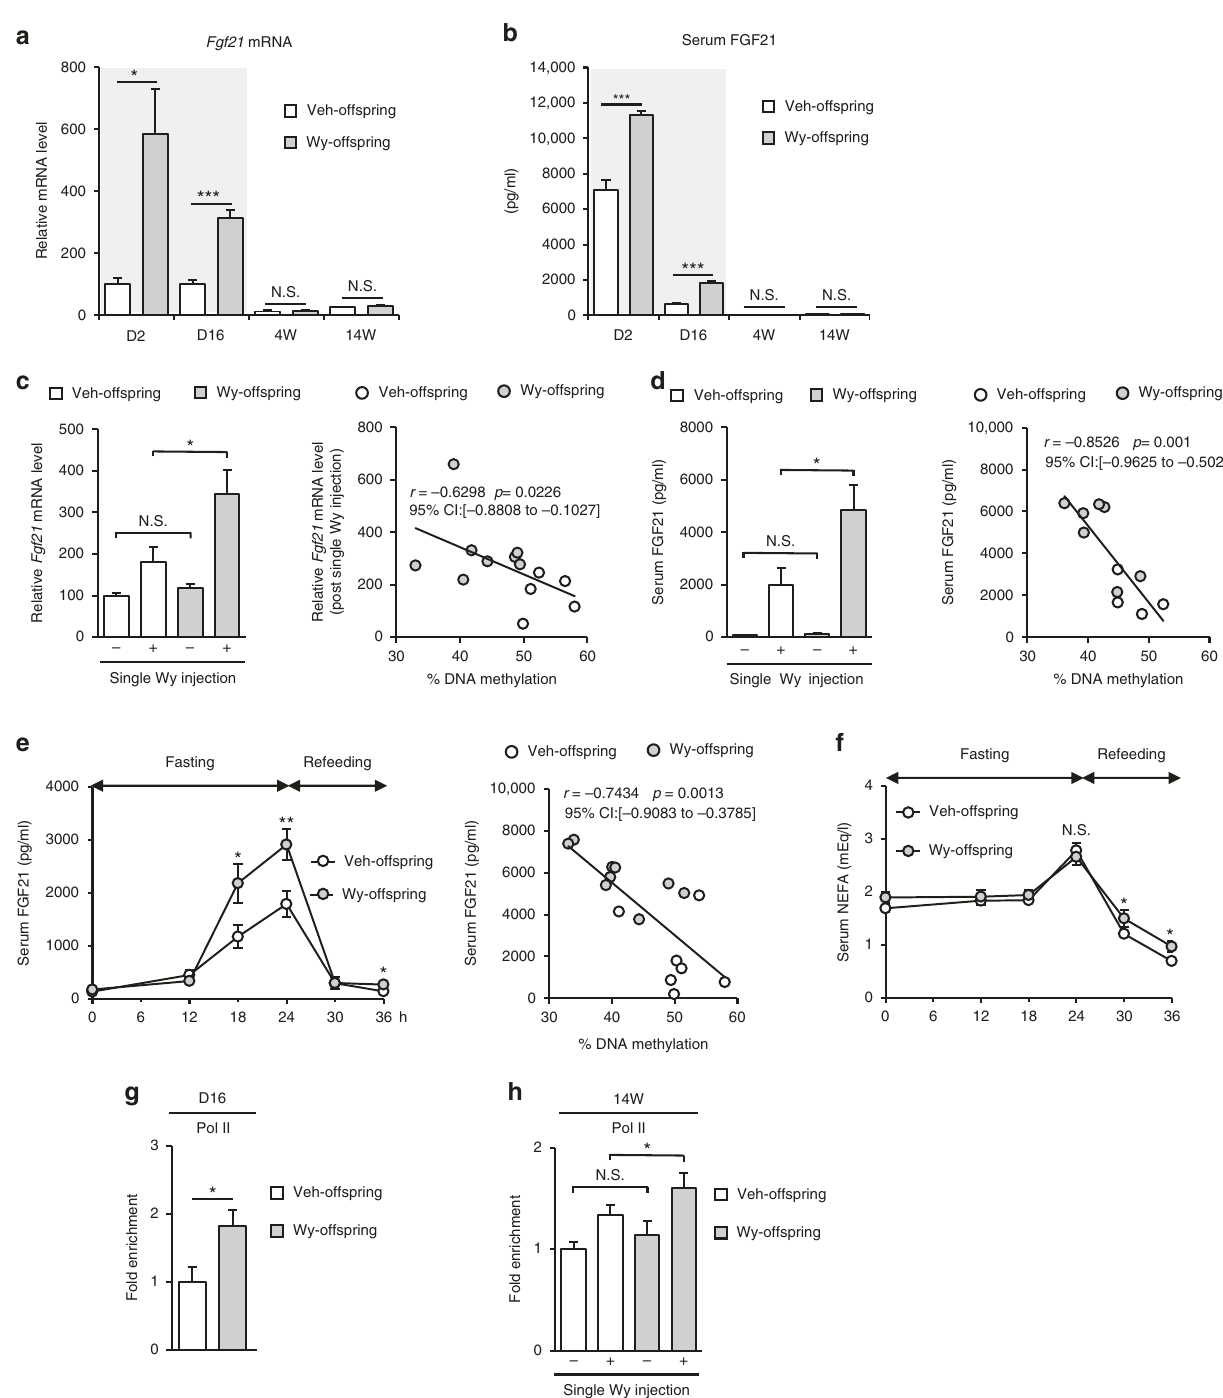
Fig. 6 Correlation between DNA methylation status of Fgf21 and FGF21 expression. a , b Hepatic Fgf21 mRNA expression and serum FGF21 concentrations in Wy- and DMSO (Veh)-treated offspring from D2 to 14W. The gray-shaded box indicates the period of maternal administration of Wy or Veh ( n = 8 per group). c Hepatic Fgf21 mRNA expression after a single Wy injection in Wy- and Veh-offspring at 14W (left, n = 5 – 8 per group). Correlation between Fgf21 mRNA expression and DNA methylation (right, n = 13). d Serum FGF21 concentrations after a single Wy injection in Wy- and Veh-offspring at 14W (left, n = 4 – 7 per group). Correlation between serum FGF21 concentrations and DNA methylation (right, n = 11). e Serum FGF21 concentrations during fasting and refeeding (left, n = 7 – 9 per group). Correlation between serum FGF21 concentrations after a 24-h fast and DNA methylation (right, n = 16). f Serum NEFA concentrations during fasting and refeeding ( n = 7 – 9 per group). g , h ChIP assays for Pol II in Wy- and Veh-offspring at D16 ( g ) and with a single DMSO (Veh) or Wy injection at 14W ( h ). Primers amplifying the region of − 106 to +21 bp were used for Pol II (Fig. 4a) ( n = 7 – 8 per group). Statistics by unpaired Student ’ s t -test ( a , b , c – e left, f , g , h ) or Spearman ’ s rank correlation coef fi cient ( c – e right). The r- and p -values are indicated on the graph. Data are expressed as mean ± SEM. * P < 0.05; ** P < 0.01; *** P < 0.001; N.S., not signi fi cant vs.